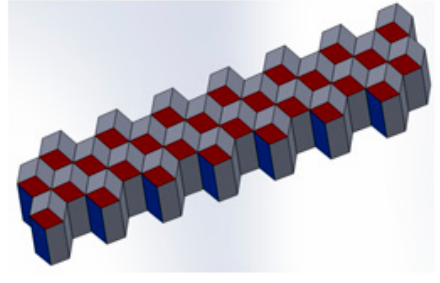
Figure 16. Double-pin group.